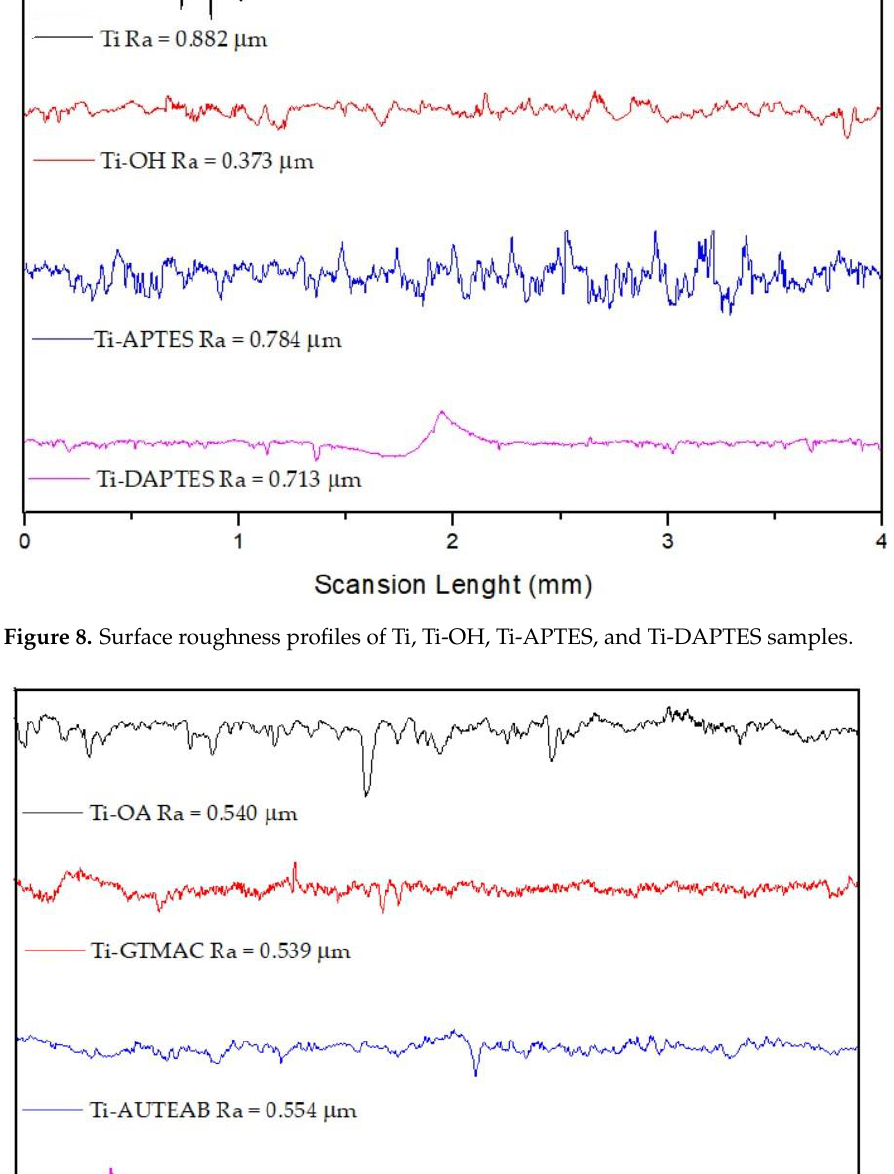
Figure 9. Surface roughness profiles of Ti-AEMAC, Ti-GTMAC Ti-AUTEAB, and Ti-OA, samples. 322